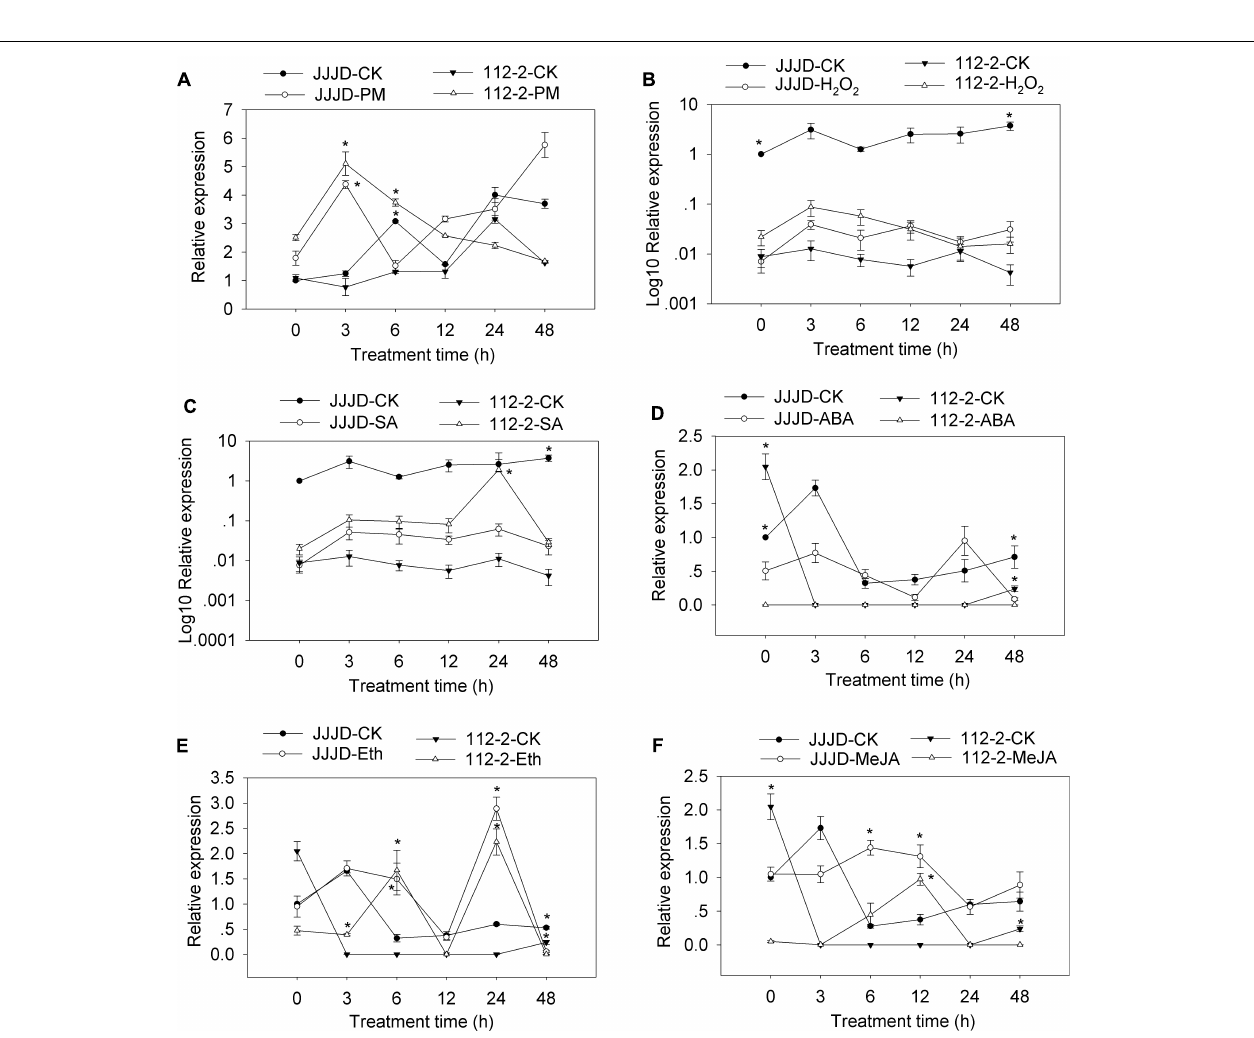
FIGURE 2 | CmSGT1 expression in response to powdery mildew and exogenous hormones. The pumpkin seedlings were sprayed with a spore suspension (A) , exogenous H 2 O 2 (B) , SA (C) , ABA (D) , Eth (E) and MeJA (F) . The pumpkin β -actin gene was used as an internal reference gene for qRT-PCR. The transcript level of CmSGT1 in the susceptible cultivar “JJJD” at 0 h is used as control (quantities of calibrator) and was assumed as 1. The relative gene expression in B and C ( Y -axis) was transformed to a log 10 scale. The values are the means ± SEs of three biological replicates. Data between treatments (112-2-treatment vs. 112-2-CK and JJJD- treatment vs. JJJD-CK) were analyzed by one-way ANOVA and ∗ denotes statistical significance at p < 0.05.